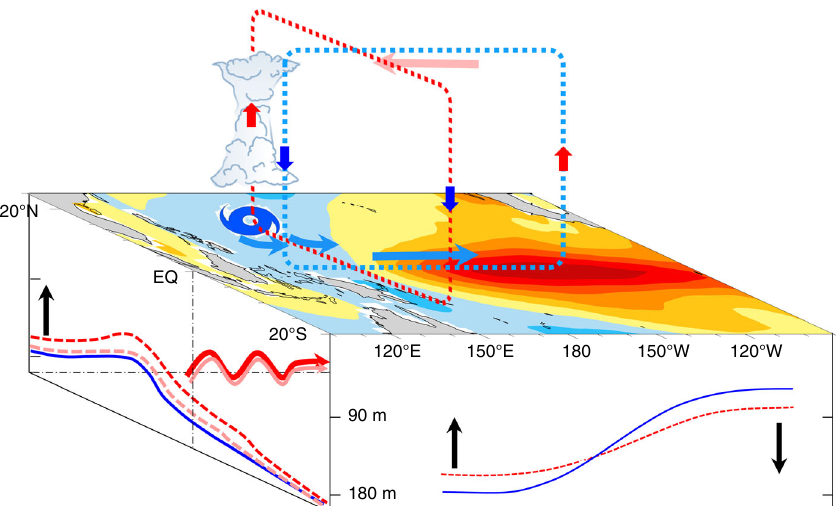
Fig. 10 Schematic diagram of the modulation of running 3-month mean SST intensity for the Niño 3.4 region (5°N − 5°S, 120° − 170°W) by tropical cyclones (TCs) over the western North Paci fi c. Walker circulation (light blue circle) is weakened by the direct effect of asymmetrically anomalous westerlies within 0° − 10°N (light blue thick arrows) related with TCs (TC symbol) at lower tropospheric levels and by the indirect effect of the Hadley-like circulation (red circle) over the tropical western Paci fi c. Red (blue) heavy arrows indicate updrafts (downdrafts). Moreover, TCs can shallow the thermocline (red dashed curve) in the tropical western Paci fi c (pink curve indicates the thermocline without TCs and blue solid line the climatological thermocline). Enhanced eastward-propagating equatorial Kelvin waves (red wavy arrow, pink wavy arrow indicates the Kelvin wave without TCs) carries warm water eastward, further deepening the thermocline in the tropical eastern Paci fi c, thereby reducing the gradient of the zonal thermocline in the equatorial Paci fi c Ocean. Both effects intensify (weaken) the El Niño (La Niña). Black arrows represent the changing direction of the